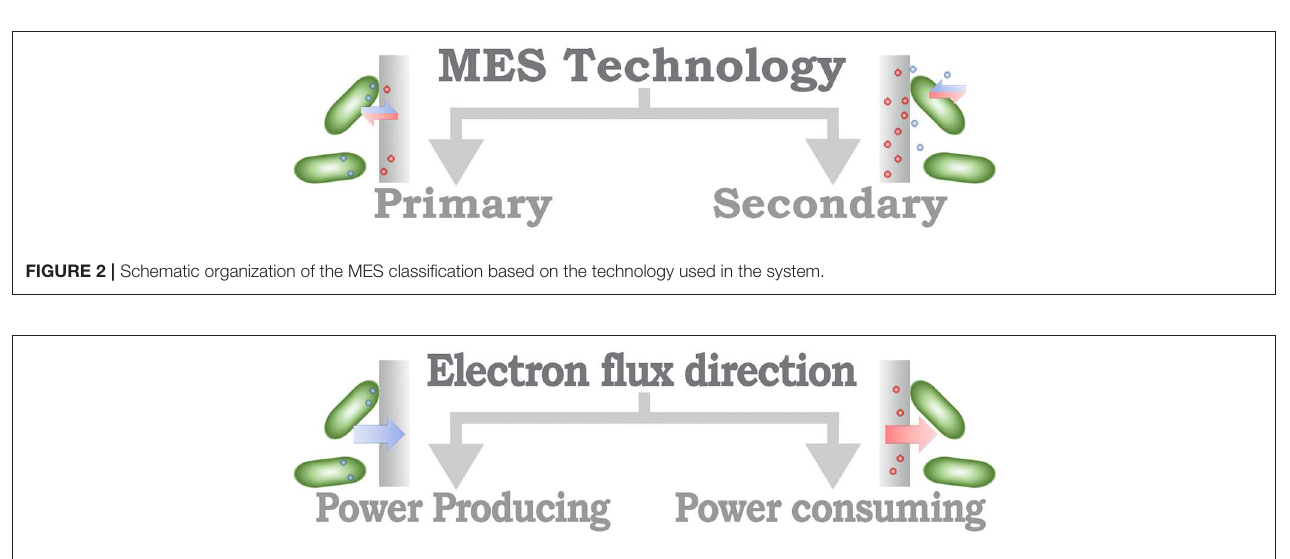
FIGURE 3 | Schematic organization of the MES classification based in the direction of the electron flux.